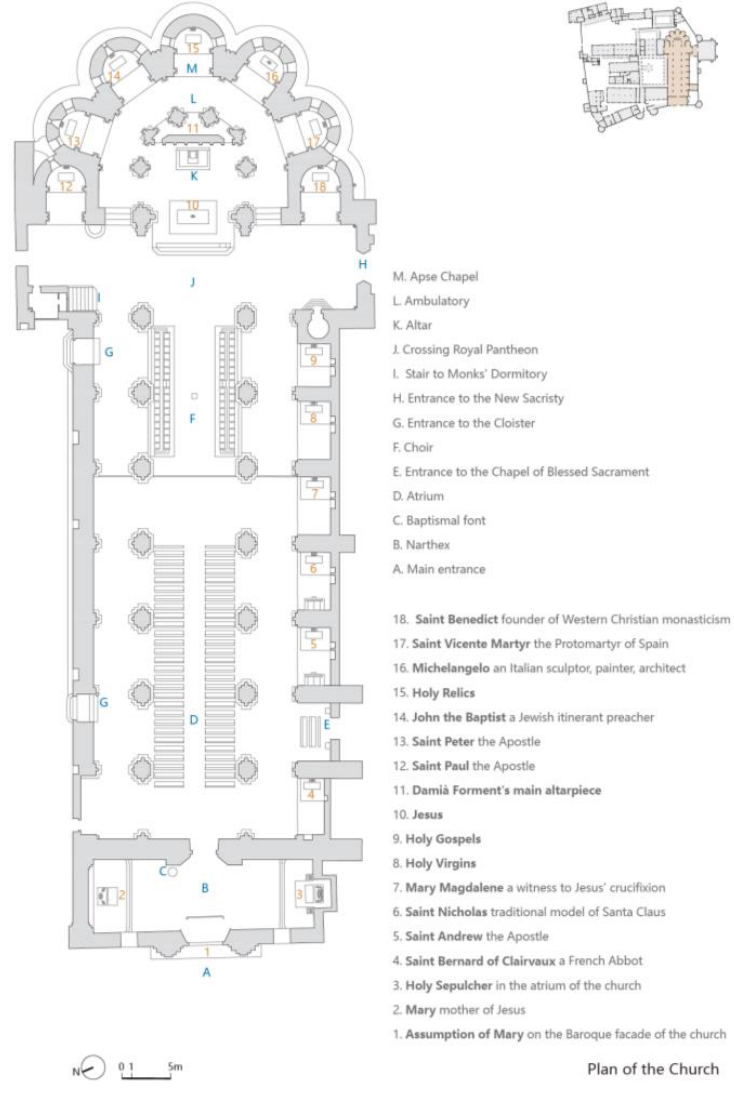
Figure 18. Plan of the Church of Poblet Monastery.